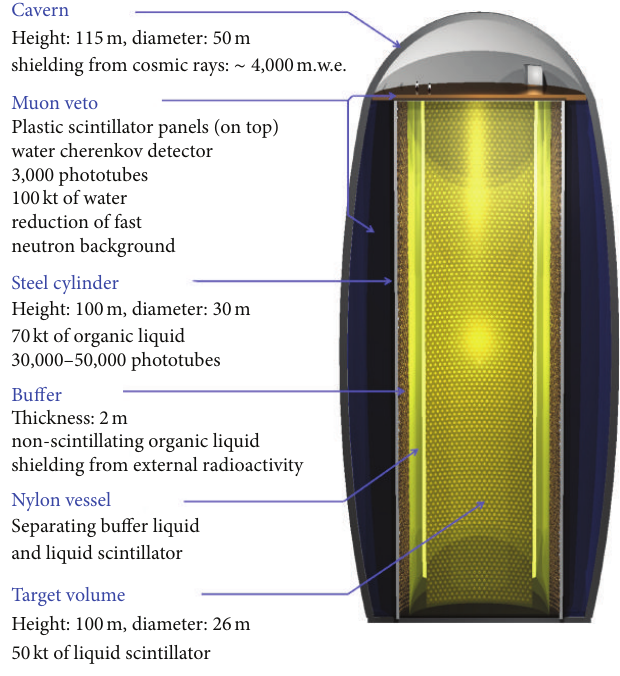
Figure 22: Schematical view of the LENA detector. From [186].